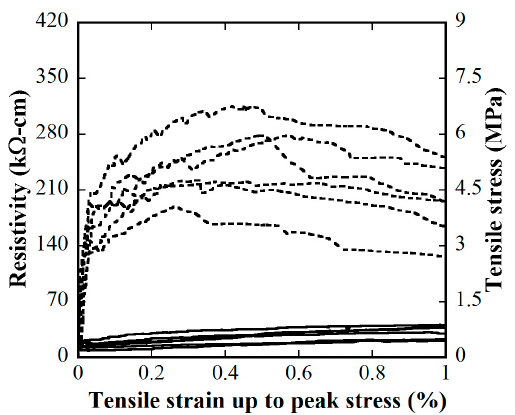
Figure 24. Electro-tensile behaviors of MSFRC2 containing MWCNTs using only water and superplasticizer.